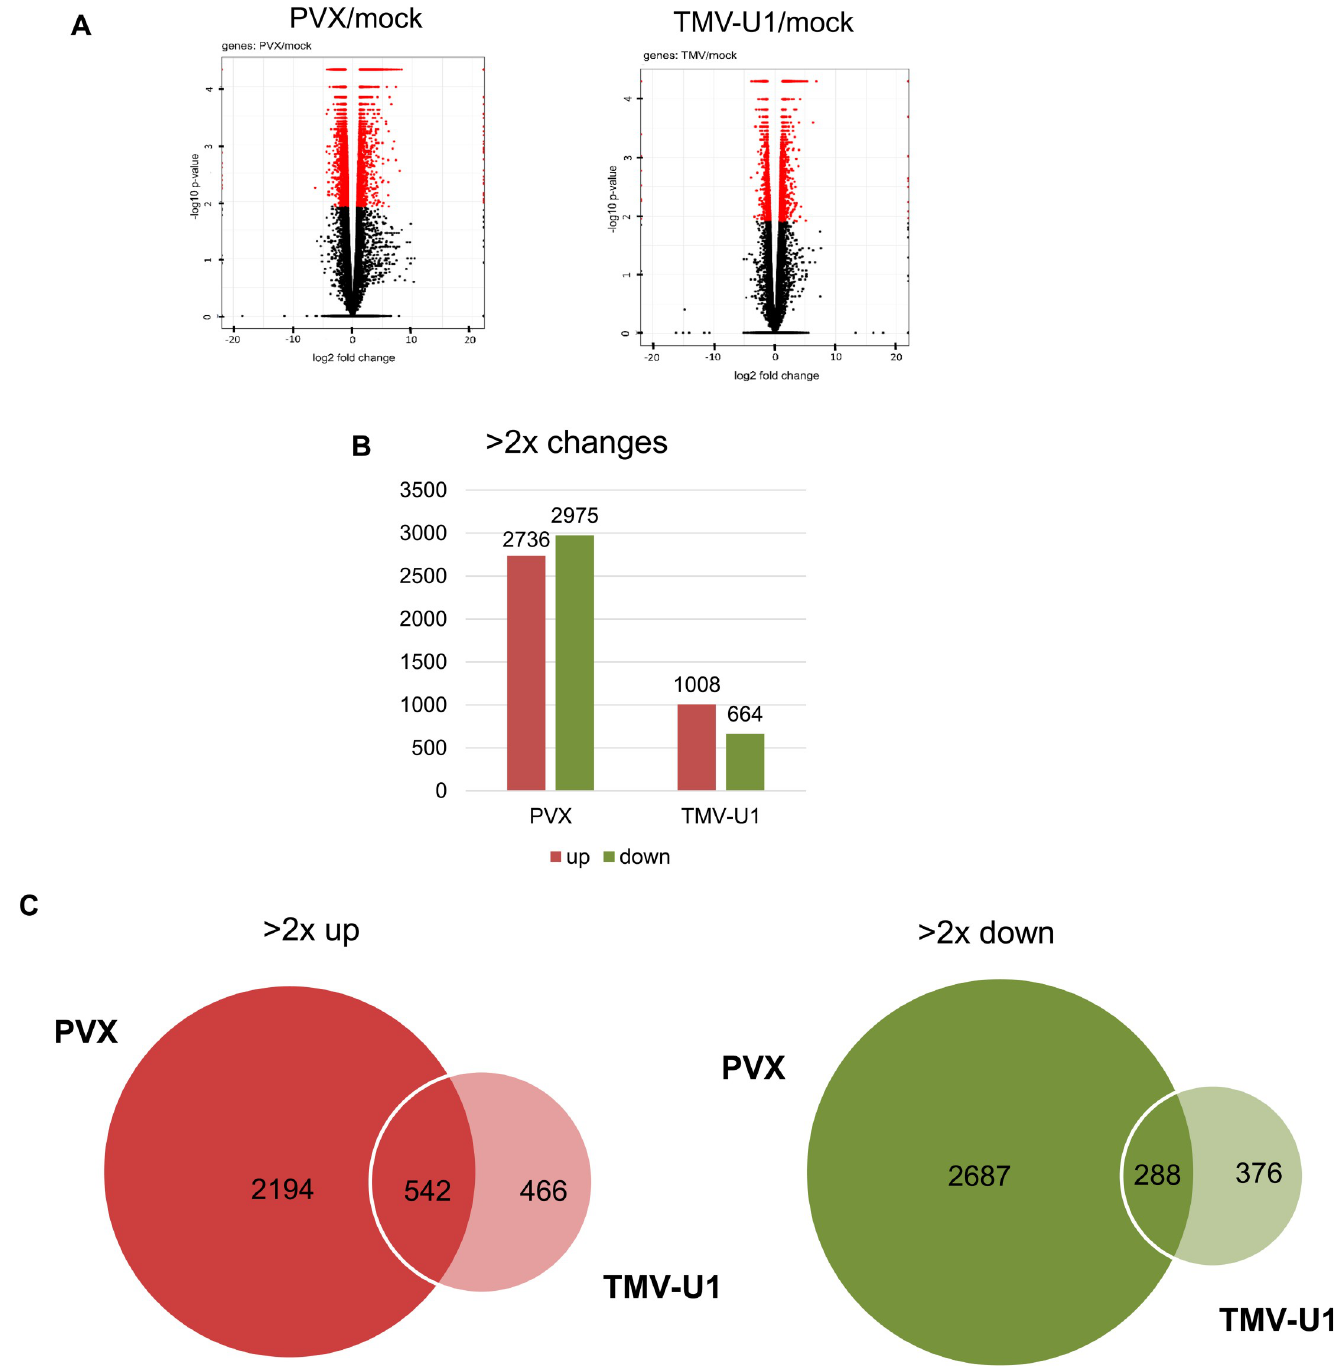
Fig 2. Gene expression changes in virus-infected S . lycopersicum plants. Differentially expressed probes were obtained by comparing the gene expression of virus- infected and mock-treated samples. Fold changes in log2 were used to generate volcano plots. Changes of more than 2-fold and p values less than 0.05 were applied to identify the DEGs. (A) Volcano plots display log2-fold changes and p values. (B) Column diagram of the number of DEGs showing at least a 2-fold change. (C) Venn diagram of DEGs identified in the virus-infected samples. Circle areas reflect the number of DEGs. All DEGs are listed with their characteristic parameters in S2 Table.